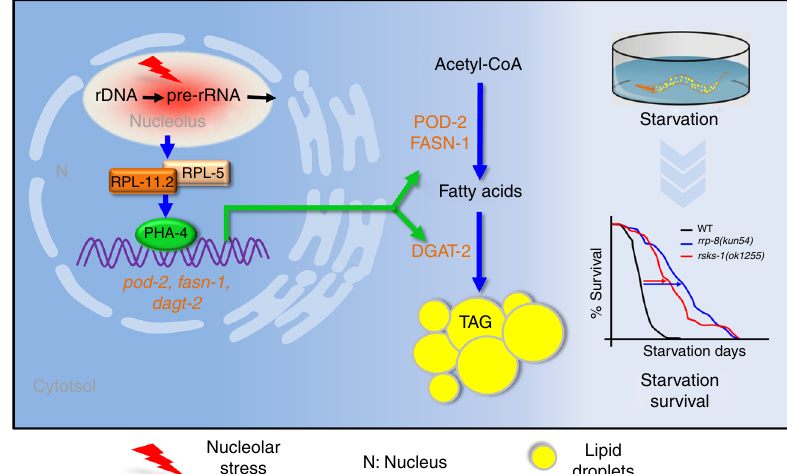
Fig. 8 A proposed model of the RPL-11.2/RPL-5-PHA-4-mediated lipogenesis pathway required for nucleolar stress-induced lipid accumulation. Nucleolar stress is triggered by perturbation of pre-rRNA transcription and processing, activates PHA-4 expression, which is mediated by RPL-11.2/RPL-5 in C . elegans . Both RPL11 and RPL5 are conserved ribosomal proteins that are required for the nucleolar stress response in mammalian cells. PHA-4 subsequently binds to and transactivates the expression of the lipogenic genes pod-2 encoding acetyl-CoA carboxylase, fasn-1 encoding fatty acid synthase, and dgat-2 encoding diacylglycerol O -acyltransferase 2. Upregulated POD-2, FASN-2, and DGAT-2 expression further promotes the biosynthesis of fatty acids and triacylglycerol (TAG), leading to excessive lipid accumulation. Furthermore, the increased lipid accumulation promotes worm survival under